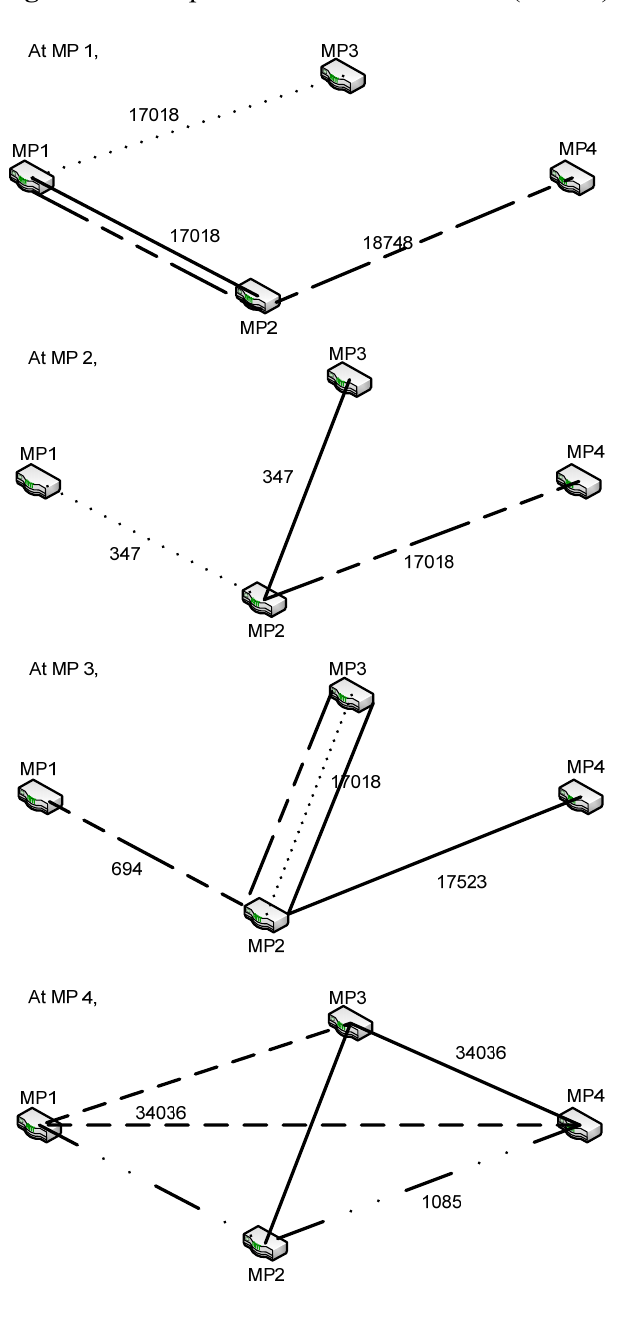
Figure 13. The path selected at each node (Trial